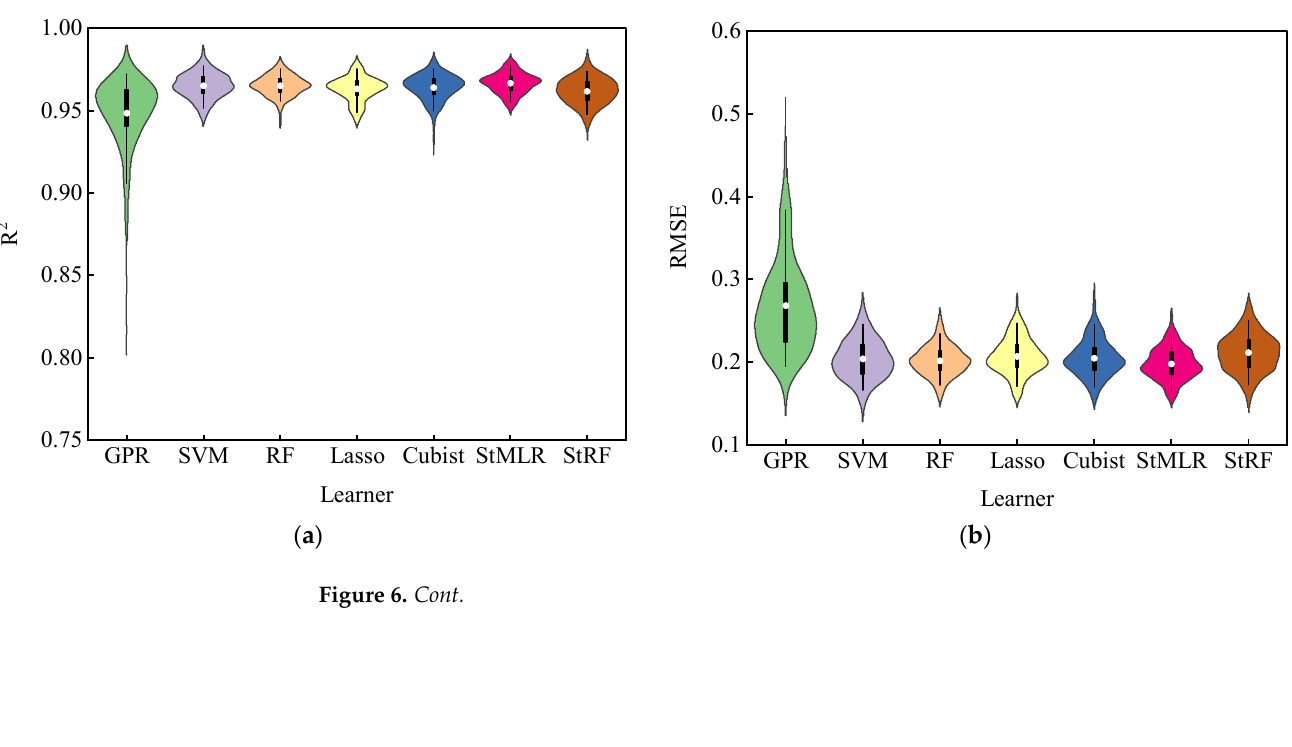
Table 8. Test set accuracy statistics of different models for LAI estimation (the accuracy parameters in this table are the average of 400 test results).